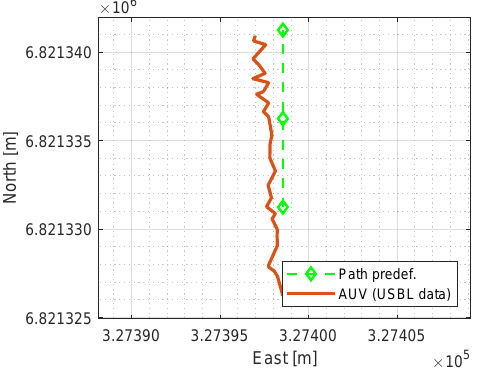
Figure 15. AUV Control scenario: AUV trajectory for the path-following